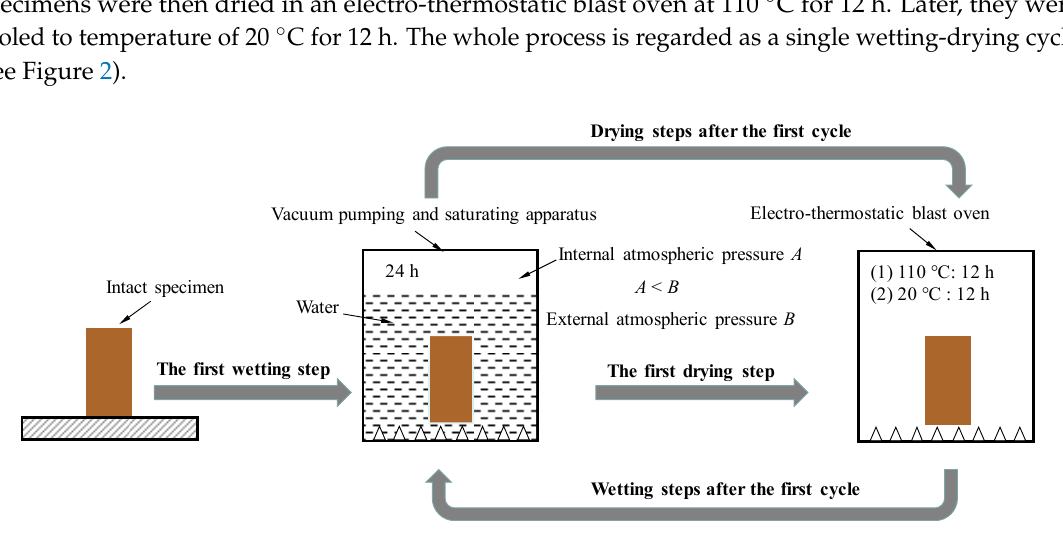
Figure 2. Schematic experimental process of the cyclic wetting-drying treatment.